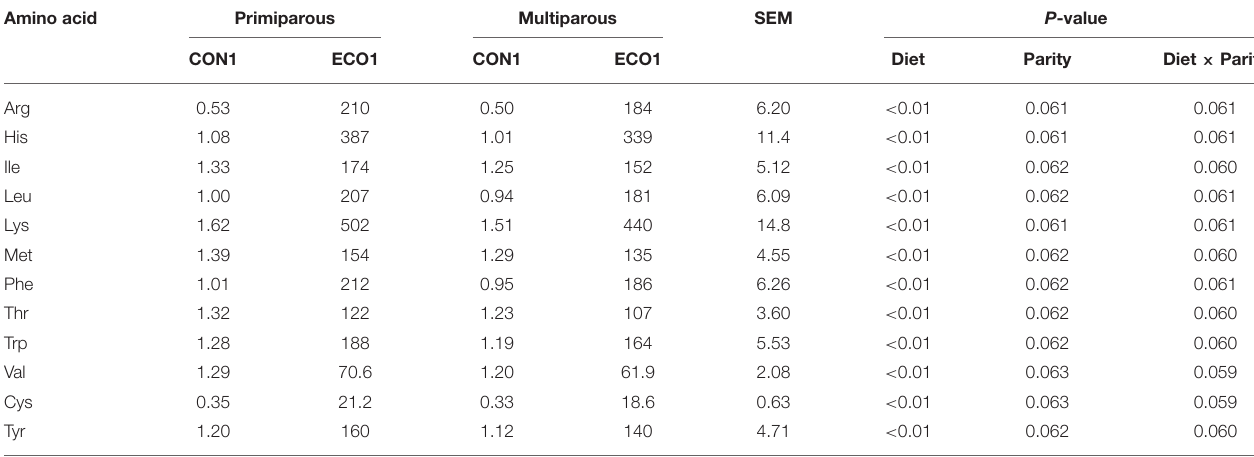
TABLE 8 | Human-edible (HE) digestible amino acid recovery (g output/g input) in milk of mid-lactation cows fed a conventional lactation diet or a by-product-based diet (Experiment 1, Choice Scenario). Amino acid Primiparous Multiparous SEM P -value CON1 ECO1